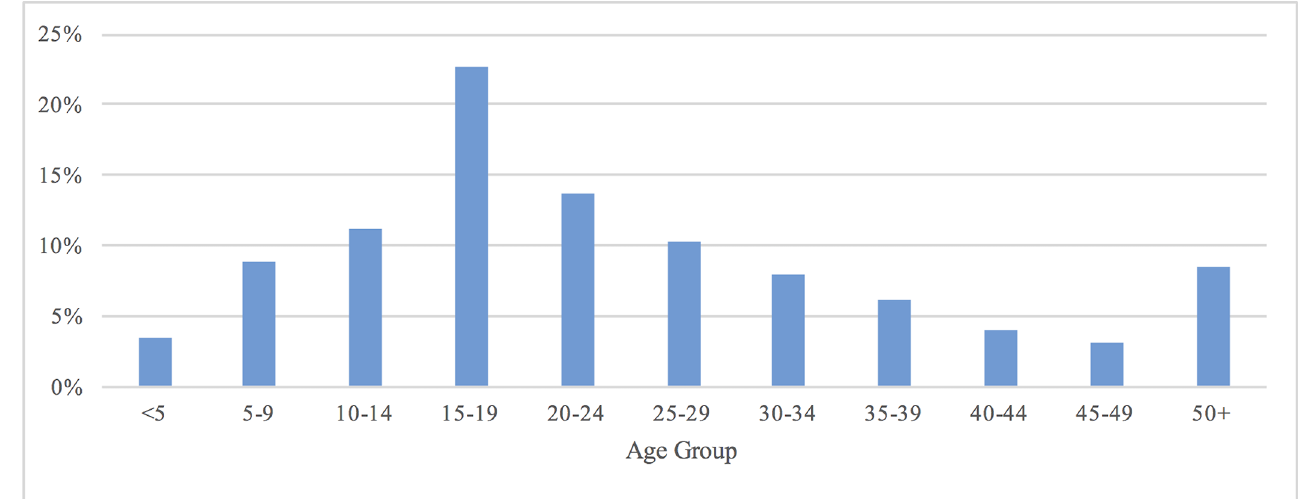
Fig 1. The age distribution of hospitalized dengue patients, Chacheongsao province, Thailand, 2015.